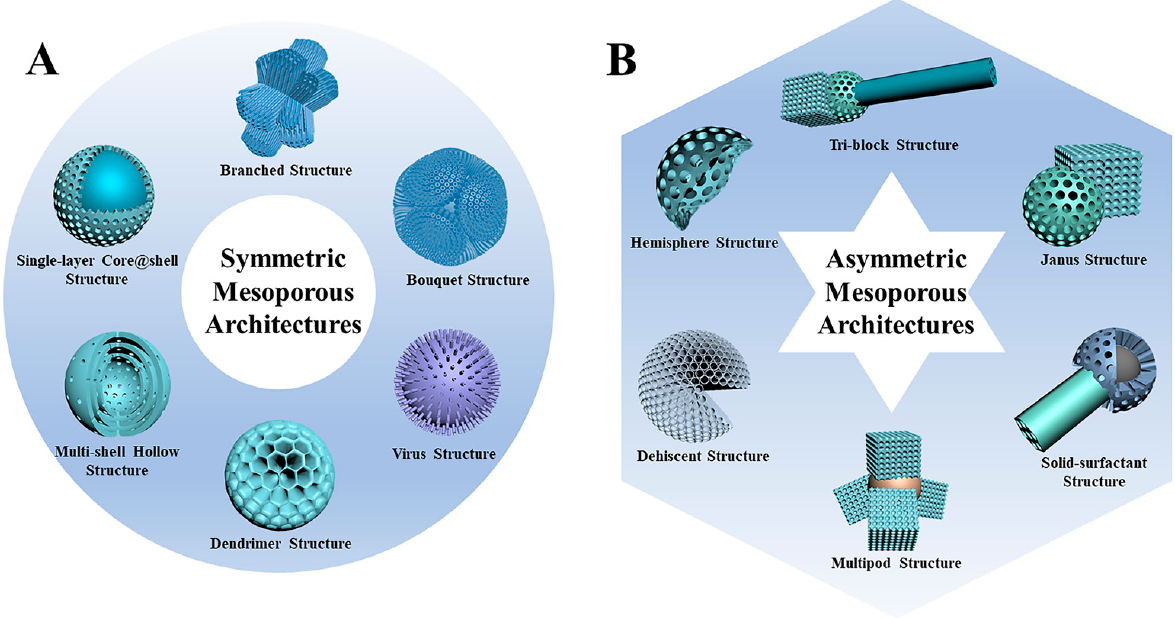
Figure 6. Schematic illustrations of ( A ) symmetric and ( B ) asymmetric mesoporous nanoparticles with various architectures [95].